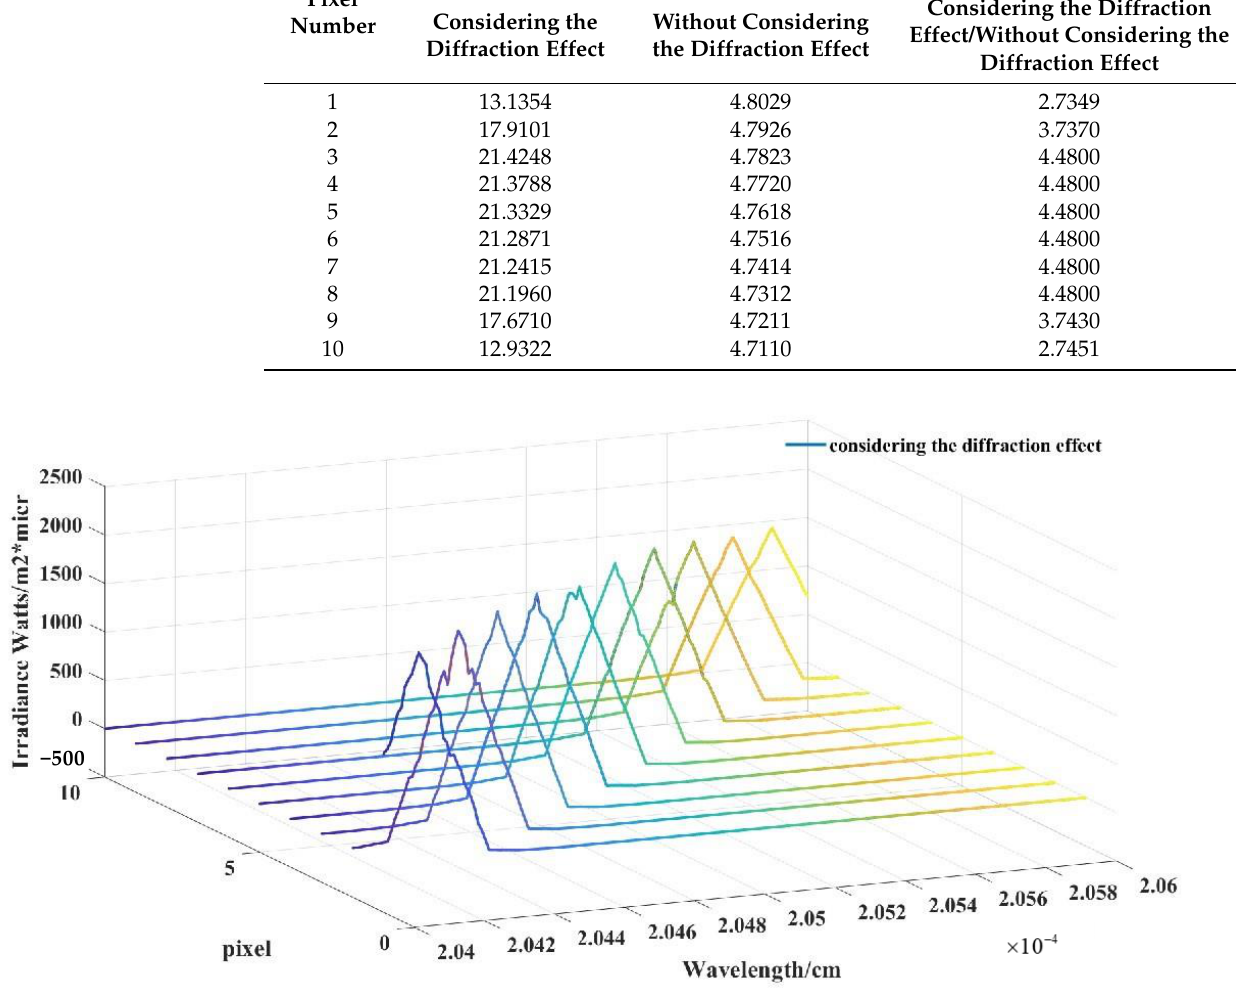
Figure 7. Real distribution, arranged by pixel.